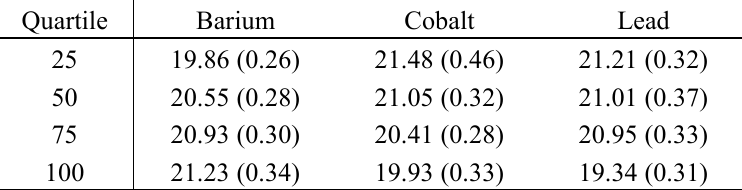
Table 10. BMI by Metal Quartiles for Adolescents. Quartile Barium Cobalt Lead